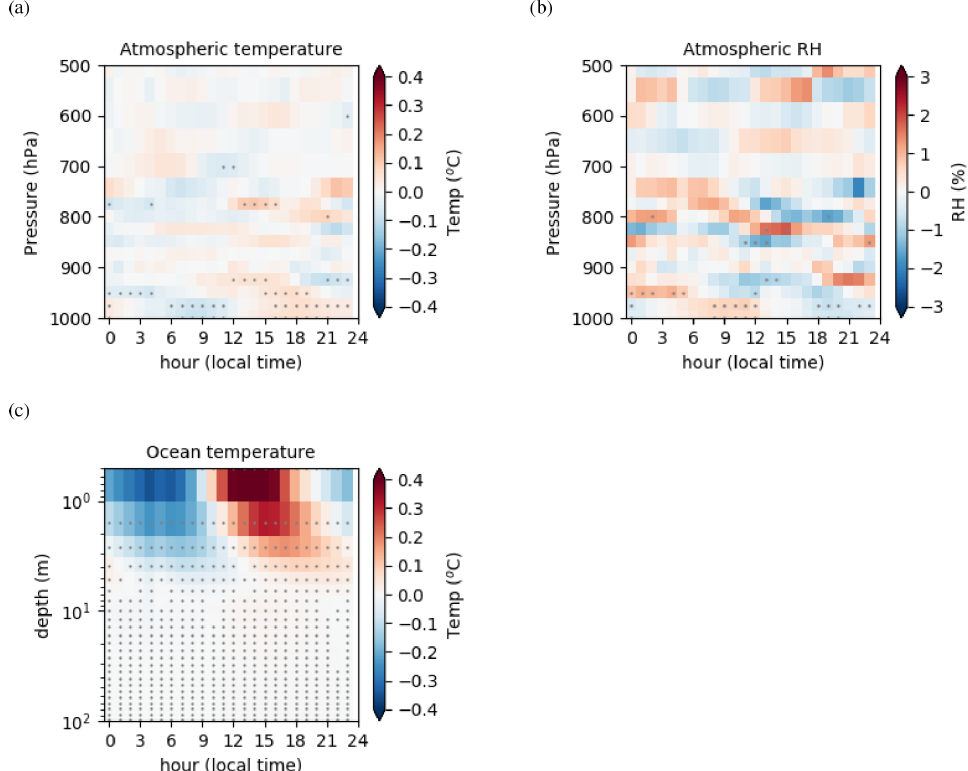
Figure 15. Change in mean diurnal cycle with the mean bias removed at each level (right column) between the 5min coupled experiment and the 1d coupled experiment for (a) the atmospheric temperature ( ◦ C), (b) the relative humidity (%), and (c) the ocean temperature ( ◦ C). Dots indicate significant differences according to a Student’s t test at the 95% confidence